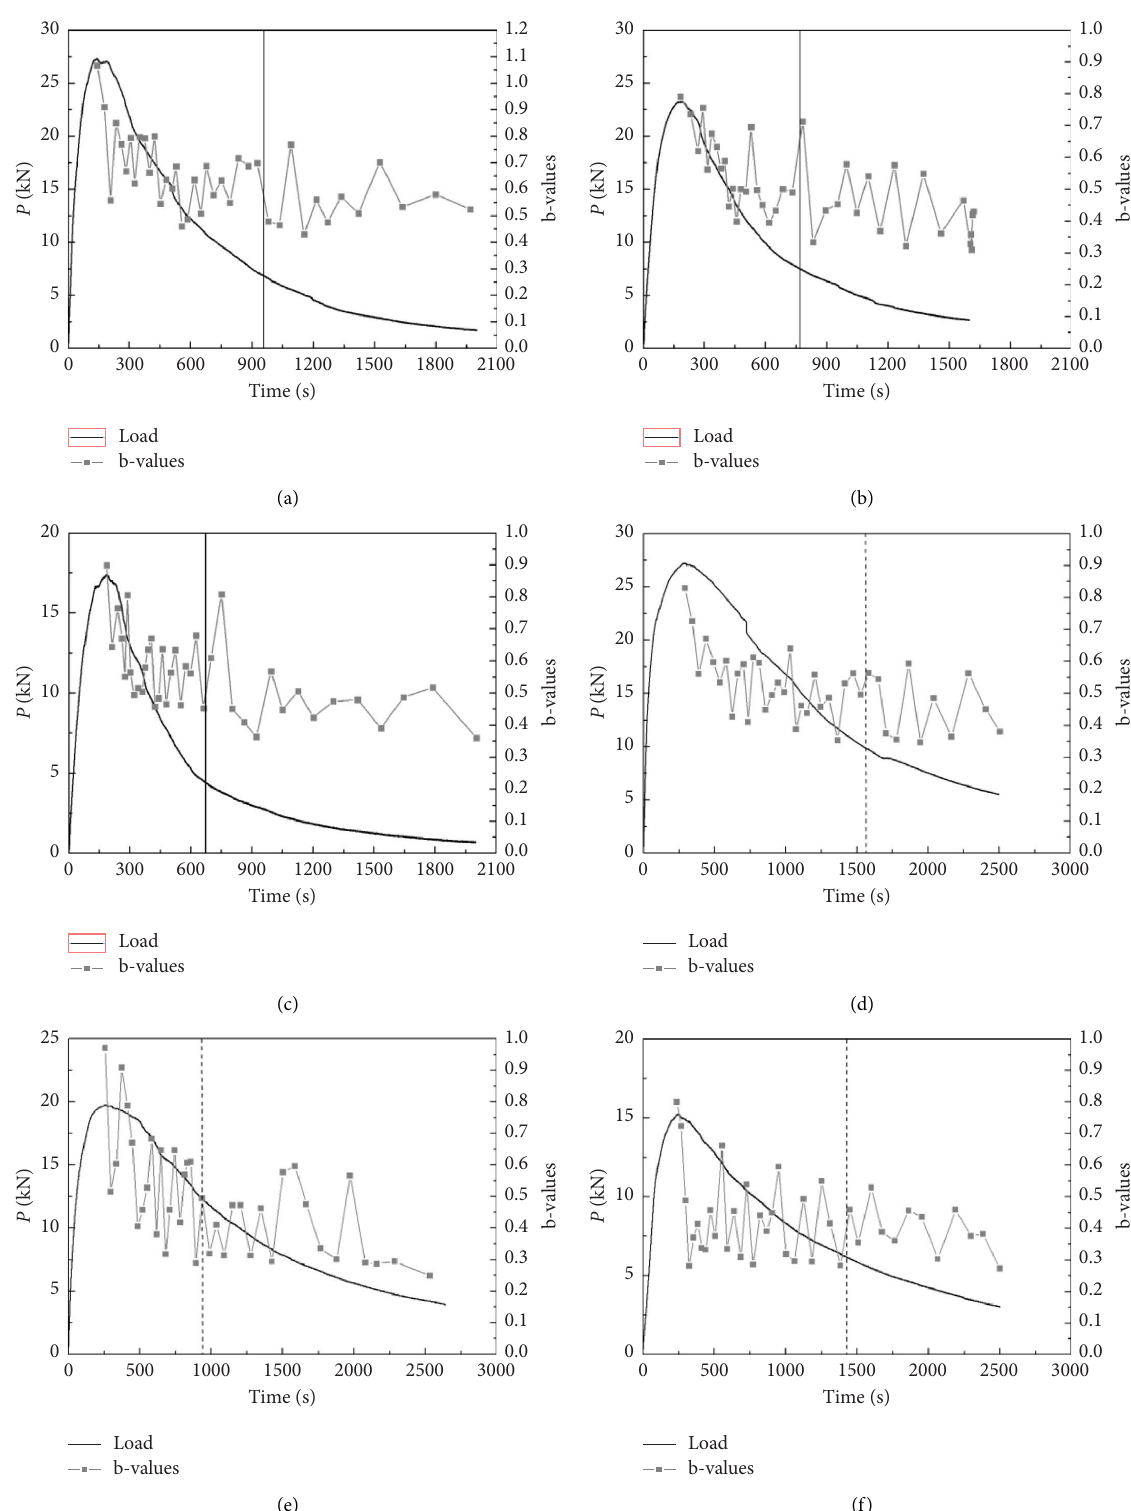
Figure 7: Te AE b value of hydraulic concrete with diferent crack-depth ratios. (a) WS300-0.3, (b) WS300-0.4, (c) WS300-0.5, (d) WS450- 0.3, (e) WS450-0.4, and (f)